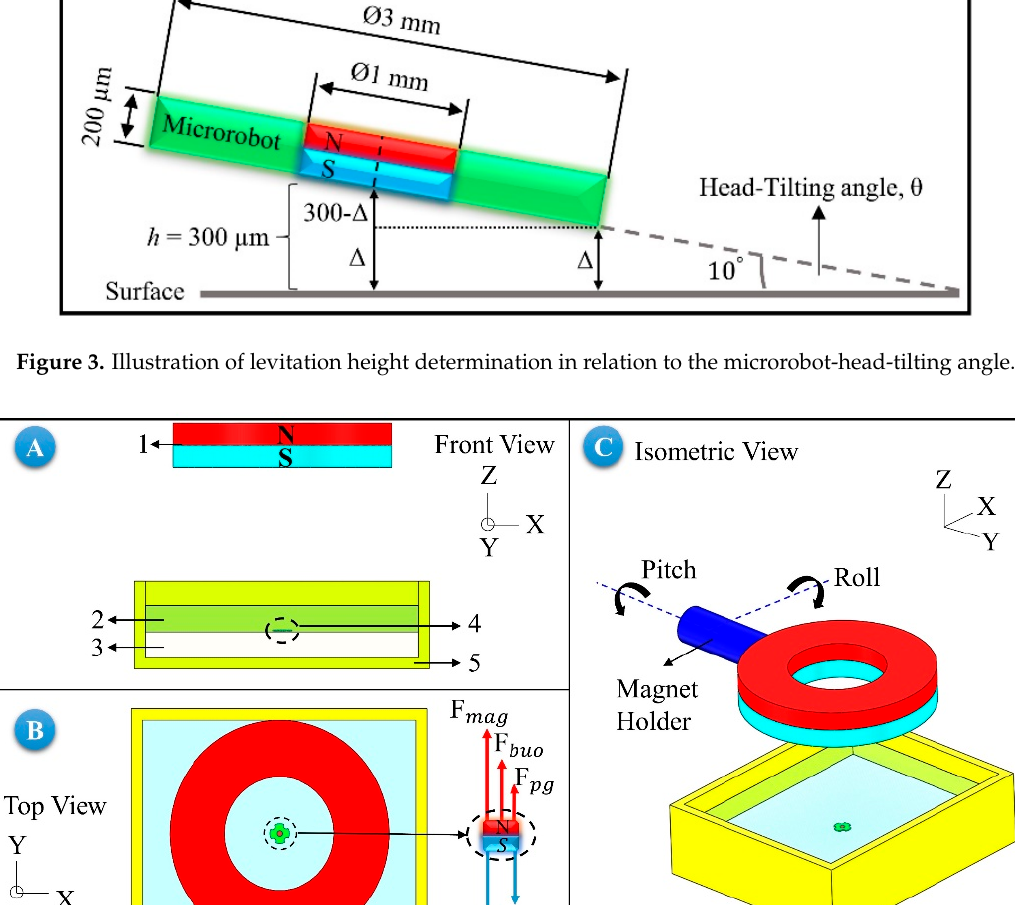
Figure 2. The angle calculation to be applied to the lifter-magnet is presented to eliminate undesired torque.